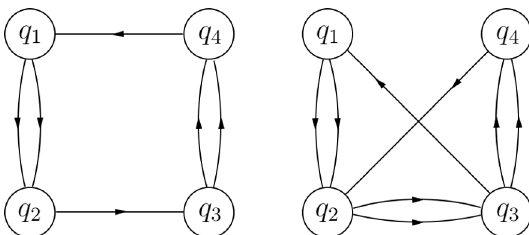
Figure 15 . These two types of quiver diagrams arise from cutting off a pair of 5d BPS states in SU(3) BPS quiver. The left one is the usual 4d BPS quiver for 4d SU(3) theory. The one on the k right is equivalent to the left via quiver mutation, to be performed on node 4, followed by a switch of the resulting nodes 3 and 4. This is of course consistent with the fact that locally the 4d holonomy saddle is always the ordinary 4d SU(3)